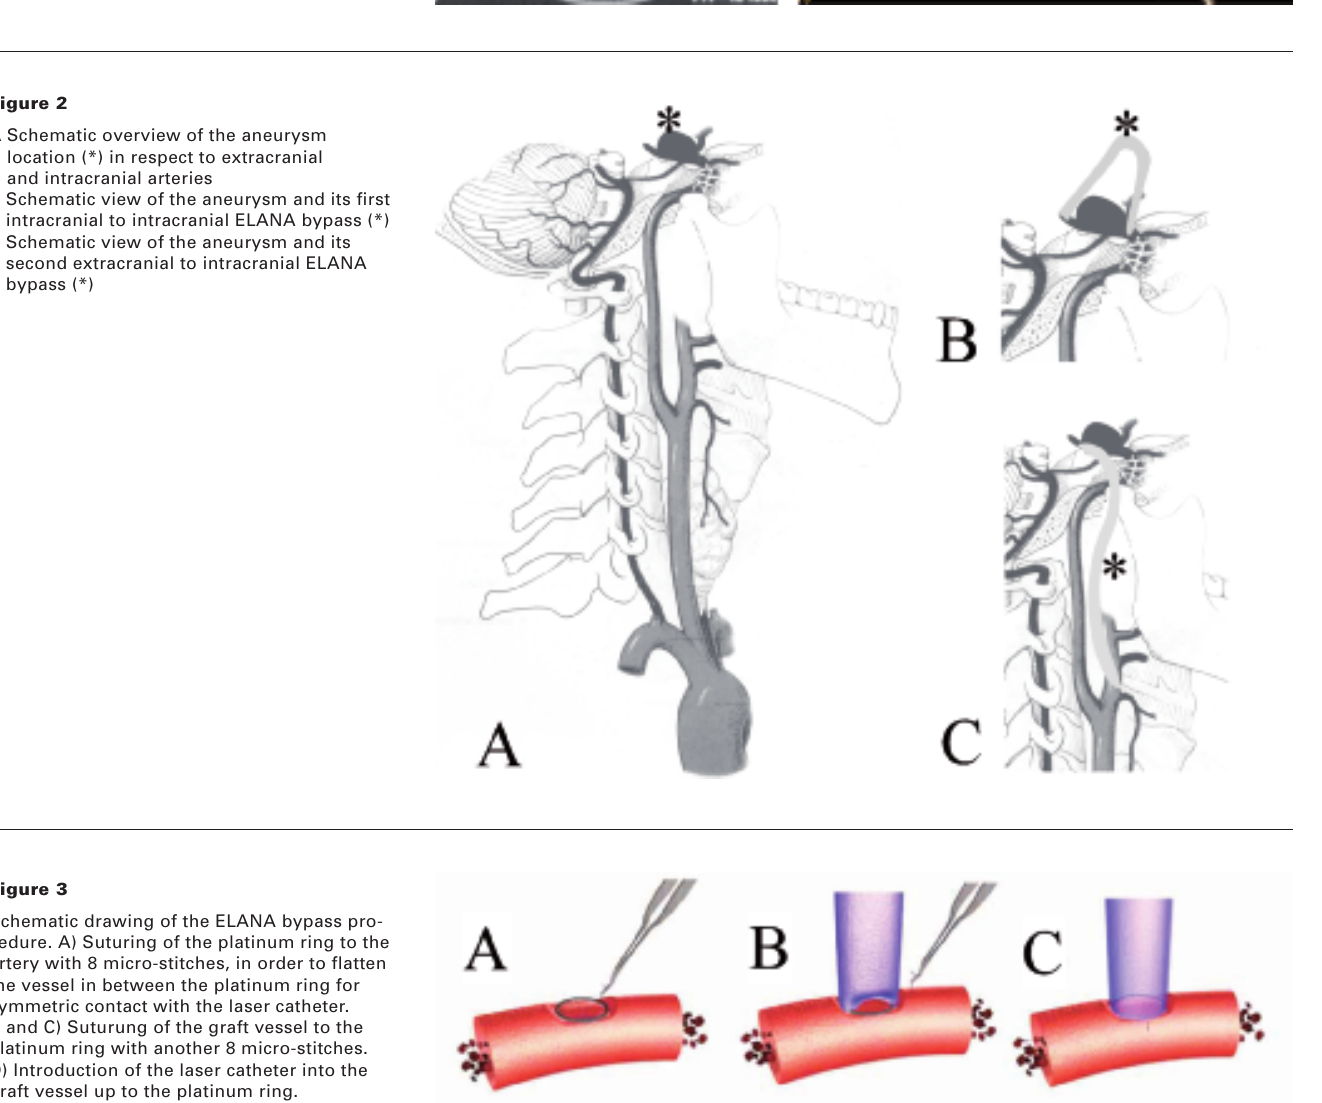
A T 1 -weighted Gadolinium-enhanced MRI of the skull showing a large mass lesion in the left temporobasal region. The mass was perfused and corresponded to a giant aneurysm. B 3D CT-angiography demonstrated the origin of the giant aneurysm at the birfurcation of the internal carotid artery (thin arrow: anterior cerebral artery; thick arrow: middle cerebral artery; double arrow: internal carotid artery end segment).